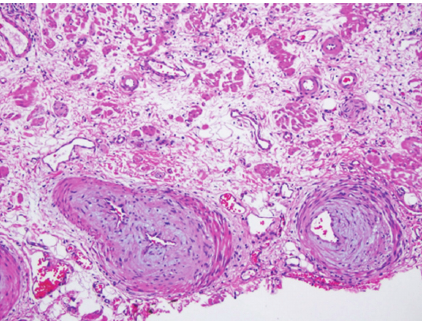
Figure 4: Hematoxylin and eosin stain shows obliterative vascu- lopathy at resection margin.